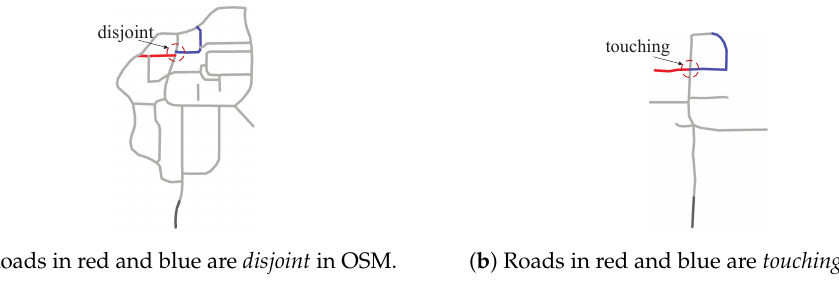
Figure 19. Different topological relationships of the corresponding two roads in OSM and